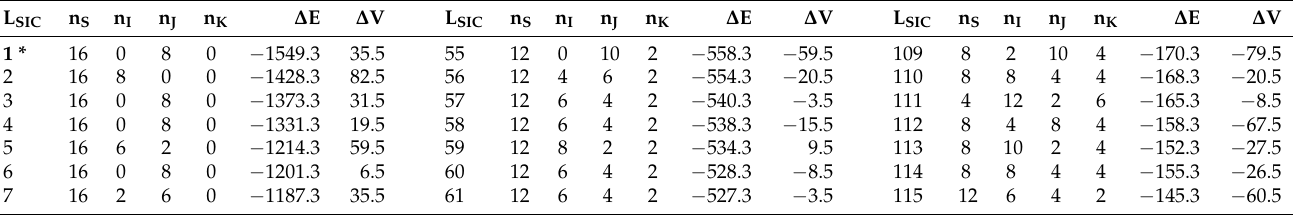
Table A3. B3LYP relative energy ( ∆ E in µ E h per 2 f.u.) and volume ( ∆ V in mÅ 3 per 2 f.u.) for the FM solution with respect to REF (in bold, E REF = − 4326.636451 E h ) of the 162 SICs labelled by increasing energy (L SIC ) and the number of the four first neighbor interactions as defined in the text (n S , n I , n J , and n K ). The star in the first column indicates the configurations investigated by Varignon et al. (see Reference [14] in the main text), labelled (i), (ii), and (iii) in their Table III. They appear at L SIC =